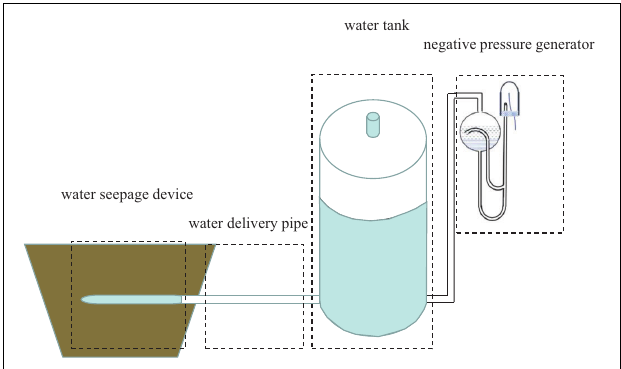
FIGURE 1 | Schematic diagram of pressure potential difference-crop initiate drawing water technology device (Wang et al.,